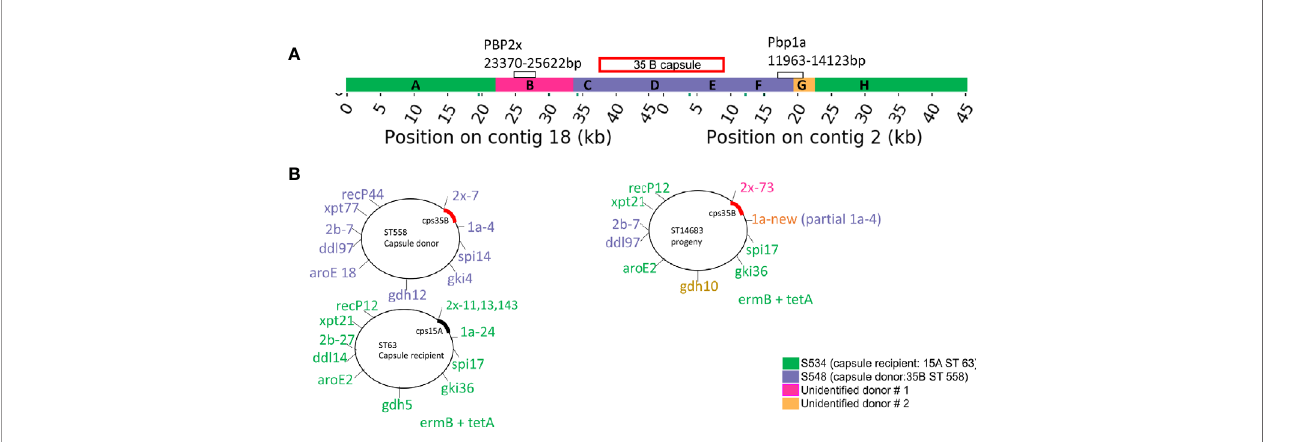
FIGURE 4 | (A) Diagrammatic representation of capsule region and adjacent regions from donor, recipient in progeny strain. (B) Combination of seven housekeeping genes and PBP genes. The diagram in (B) represents our interpretation of the source of each of these regions. The region that is homologous to the capsule donor to the recipient is purple and corresponds to regions C – F in Supplementary Figure 1 . The regions that are homologous to the recipient strain are orange and correspond with regions A and H in Supplementary Figure 1 . Regions B (pink) and G (yellow) have limited homology to both the donor and recipient, which probably means that they came from one or more unidenti fi ed